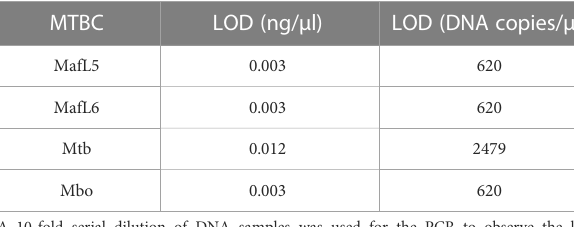
TABLE 3 Results showing LOD of PCR